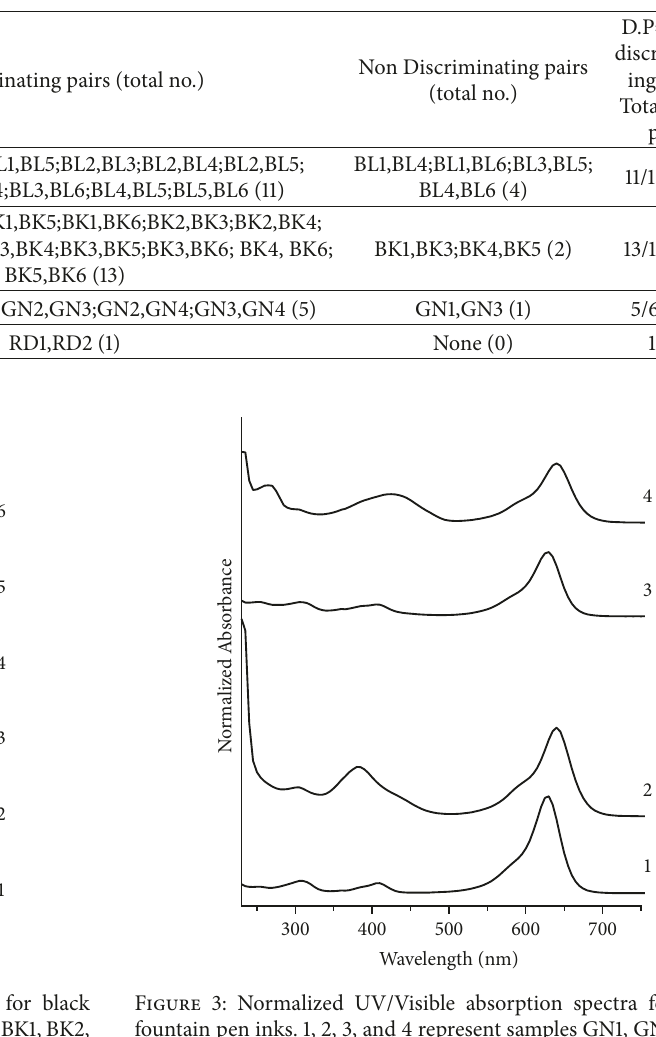
Table 3: Discriminating power for blue, black, green and red inks using UV/Visible spectroscopy.